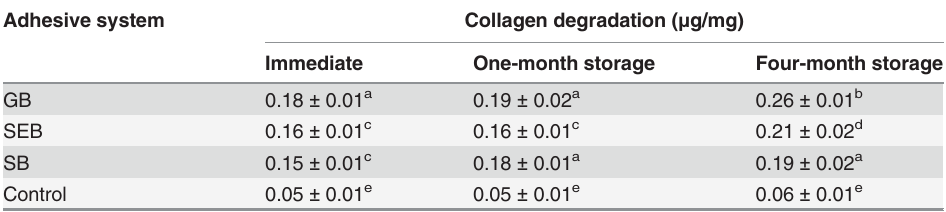
Table 6. Collagen degradation of each group measured by ELISA (n = 6, x ̄ ± s). Adhesive